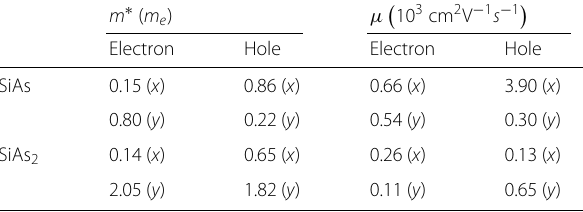
Table 1 Effective masses m ∗ and carrier mobilities μ of SiAs and SiAs 2 , obtained using the PBE calculation at T =